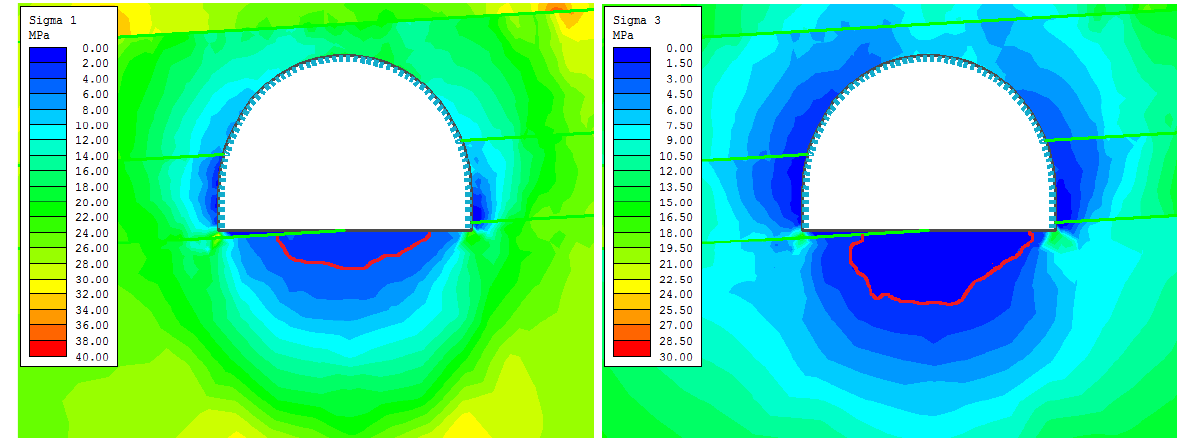
Figure 28. The extent of the failure zone in the floor of roadway F-33 — stage 1.